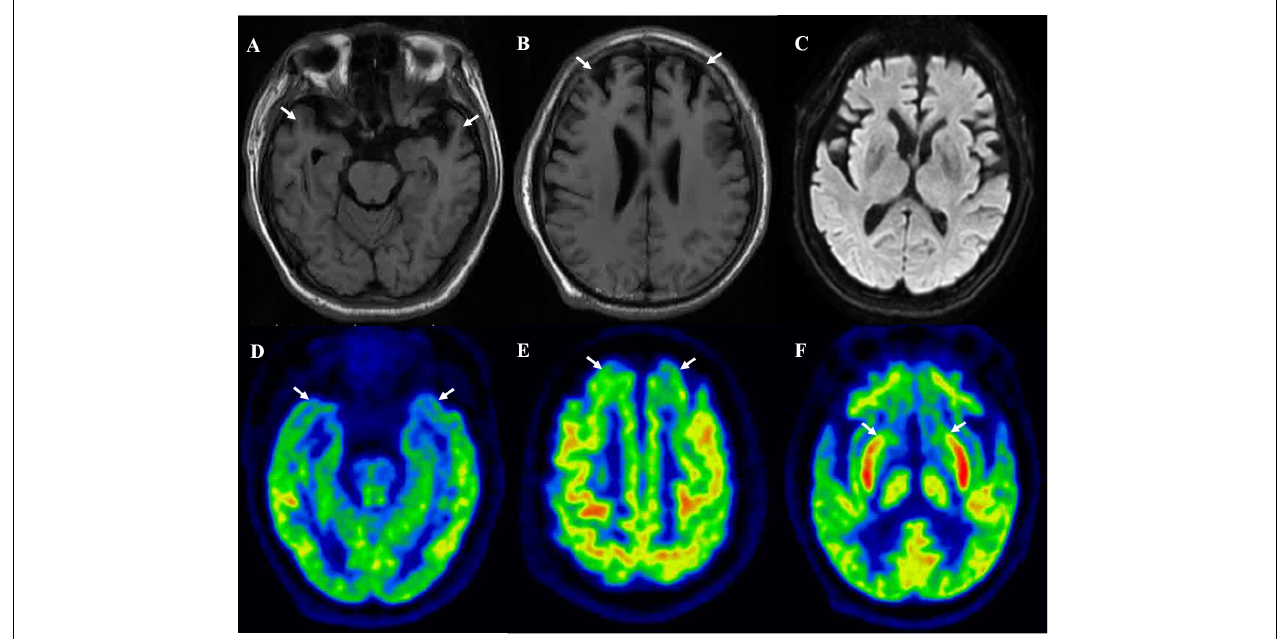
FIGURE 1 | Brain MRI suggested bilateral frontal (B) and temporal (A) lobes atrophy, and no hyperintensity was detected in diffusion-weighted imaging (C) . [ 18 F]-FDG-PET/MRI suggested bilateral frontal lobe (E) , temporal lobe (D) , and caudate nucleus (F) hypometabolism.